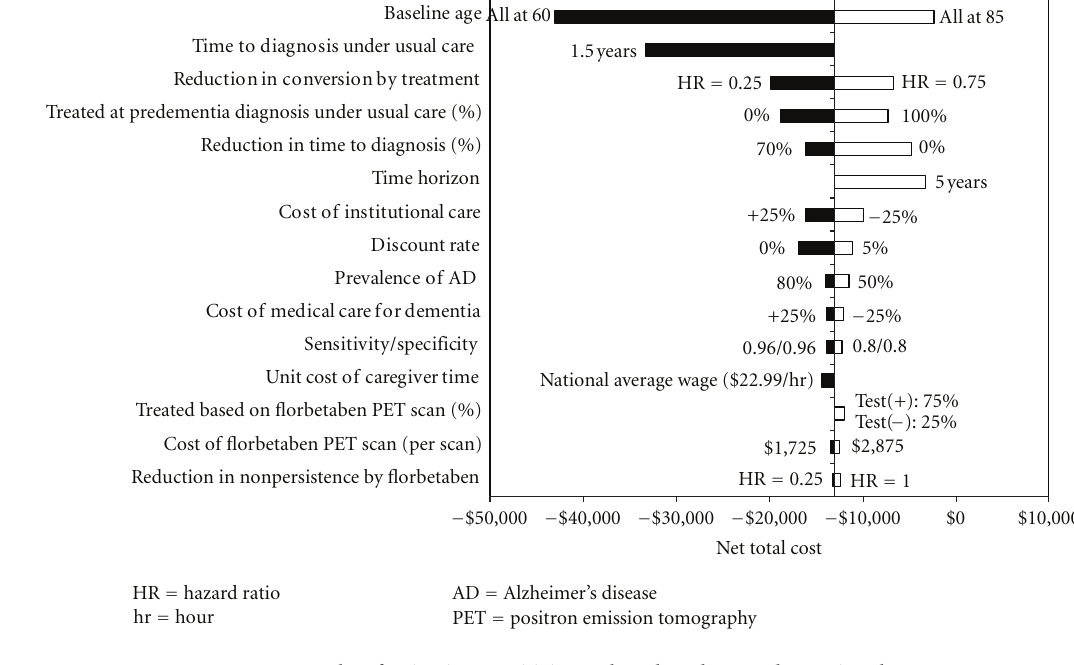
Figure 2: Results of univariate sensitivity analyses based on predementia cohort.